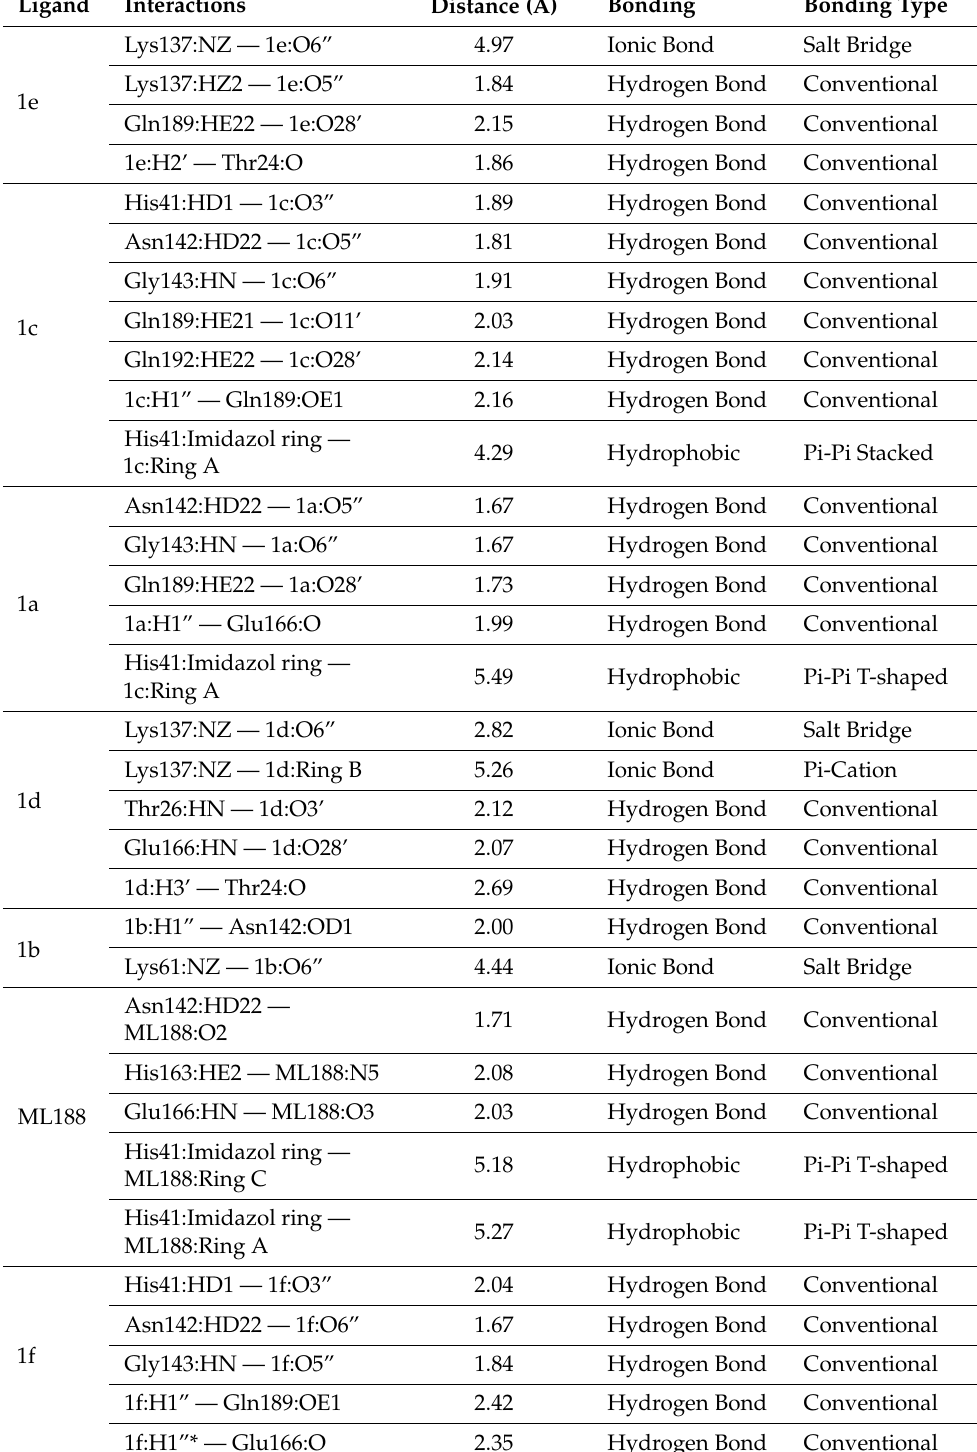
Table 2. Non-covalent interactions of the new triterpene amides and the ML188 inhibitor with amino acids of the SARS-CoV-2 Mpro active site as a result of molecular docking. The atomic numbering of the new compounds and the ML188 inhibitor are given according to Figures 1 and